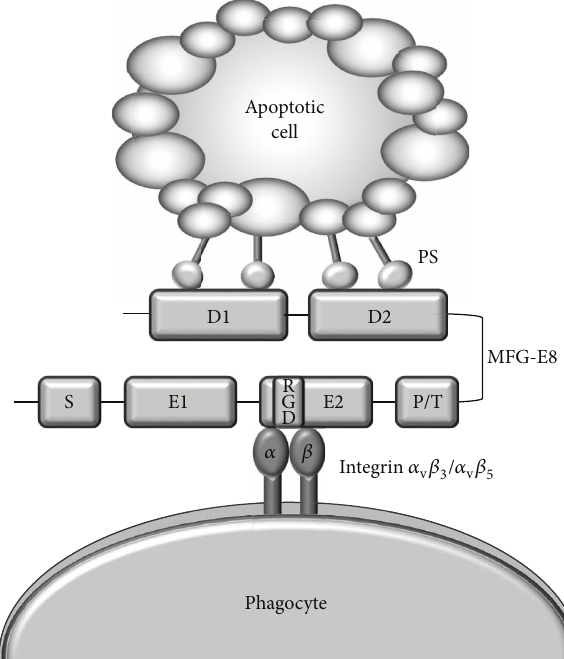
Figure 2: Mechanism of action of